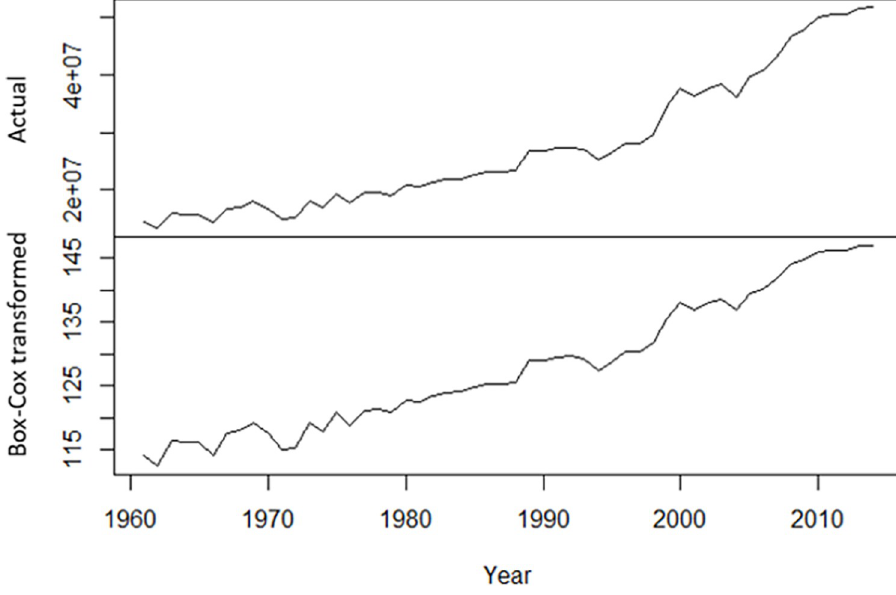
Fig 4. A comparison between the Box-Cox transformed sequence and the original sequence of annual rice production in Bangladesh.